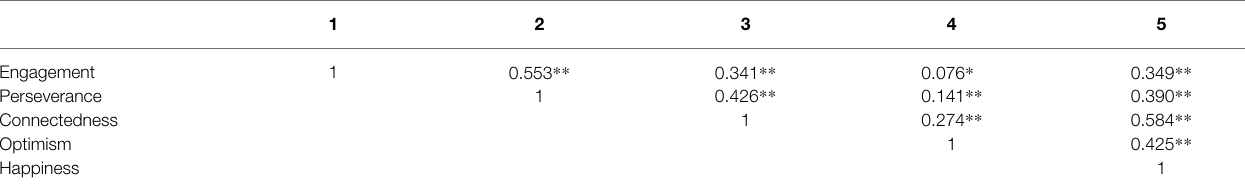
TABLE 3 | Correlations between EPOCH-S dimensions.